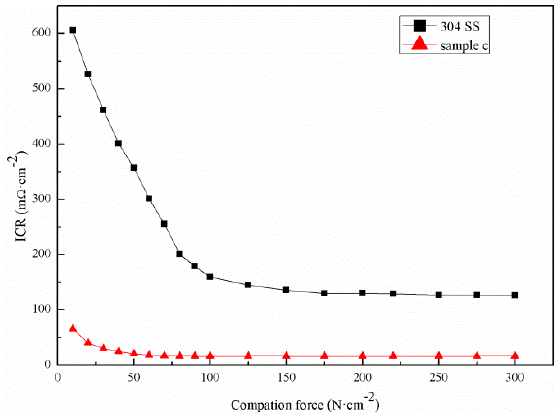
Figure 9. Contact resistance between the sample and the carbon paper at different pressures.